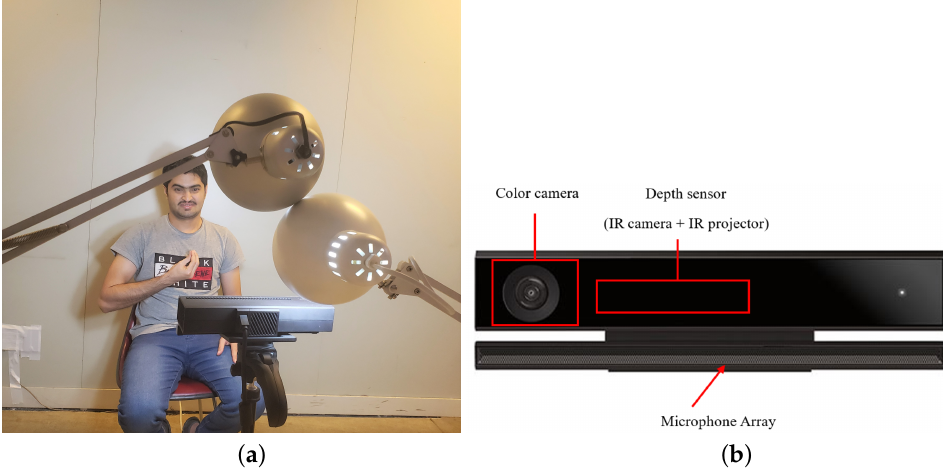
Figure 2. Acquisition environment and system: ( a ) Recording room, and ( b ) Kinect V2